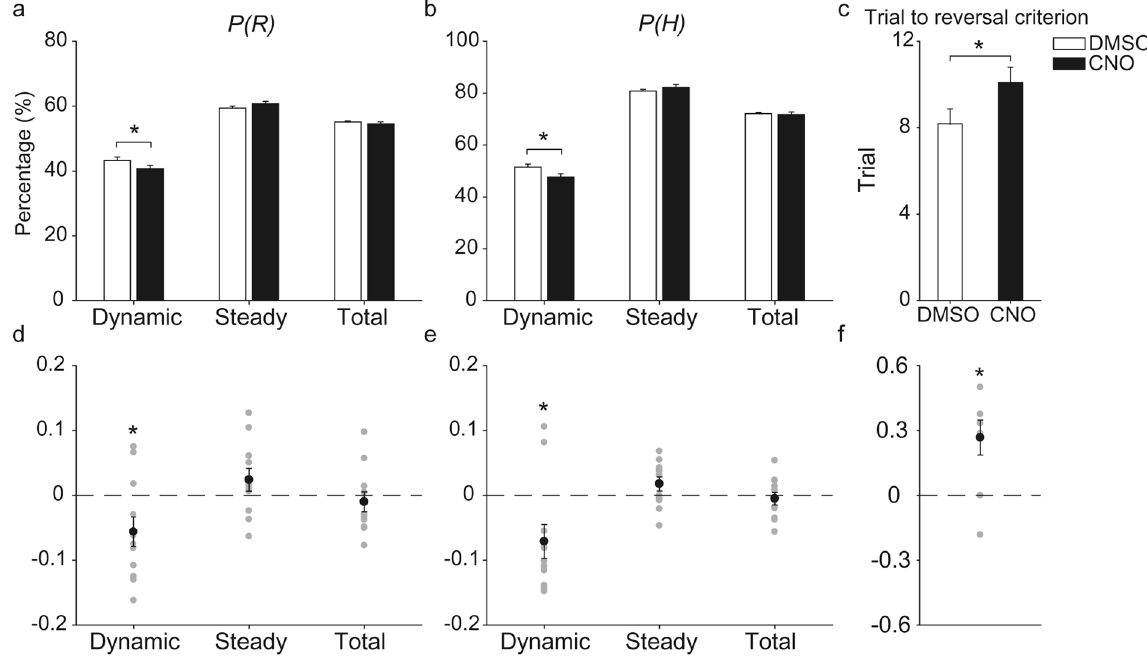
Figure 4. Effects of CA1 inactivation on choice behavior. ( a , b ) Proportions of rewarded trials ( P(R) ), ( a ) and higher-reward-probability target choices ( P(H) ), ( b ) are shown for all (Total), dynamic-state (Dynamic), and steady-state (Steady) trials (mean ± SEM across 11 CaMKIIa-Cre mice). ( c ) The number of trials to reach the reversal criterion (see Methods) after block transition (mean ± SEM across 11 CaMKIIa-Cre mice). ( d , e ) Normalized changes in P(R) and P(H) (( P(R) CNO − P(R) DMSO )/ P(R) DMSO and ( P(H) CNO − P(H) DMSO )/ P(H) DMSO , respectively) shown for each animal (gray circles). ( f ) Normalized change in the number of trials to